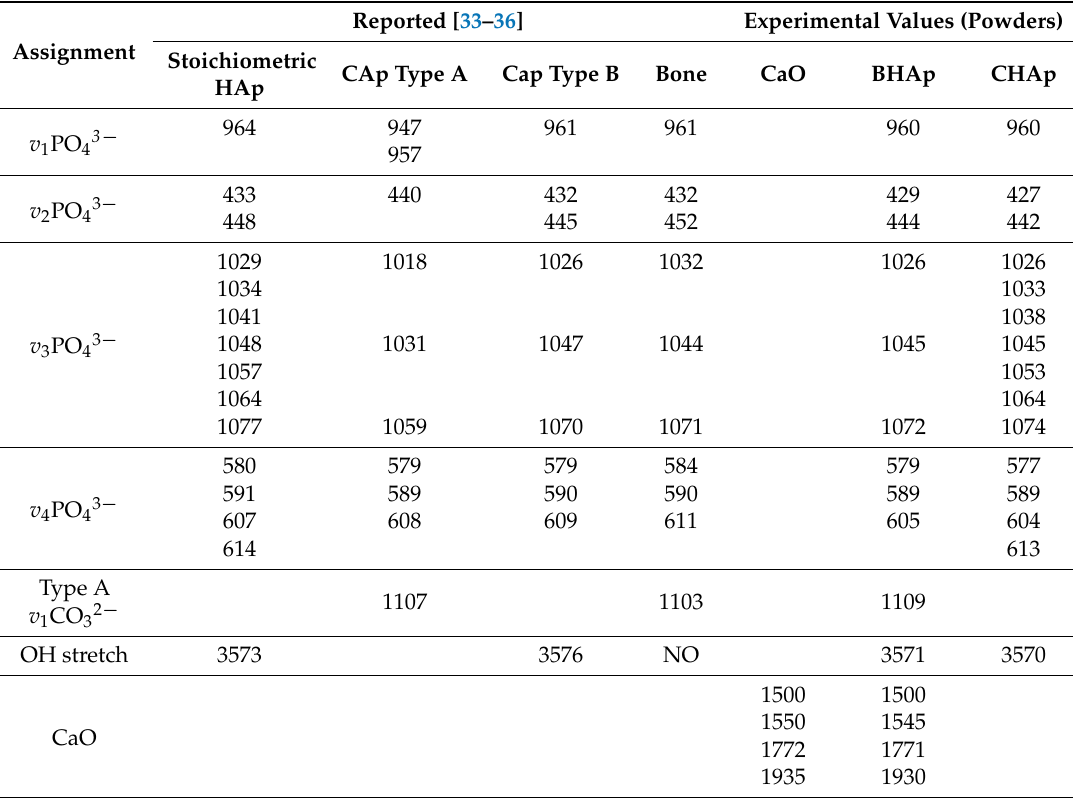
Table 4. Comparison of Raman spectroscopic band assignments for stoichiometric HAp, carbonated HAp type A and B, bone and experimental values from BHAp and